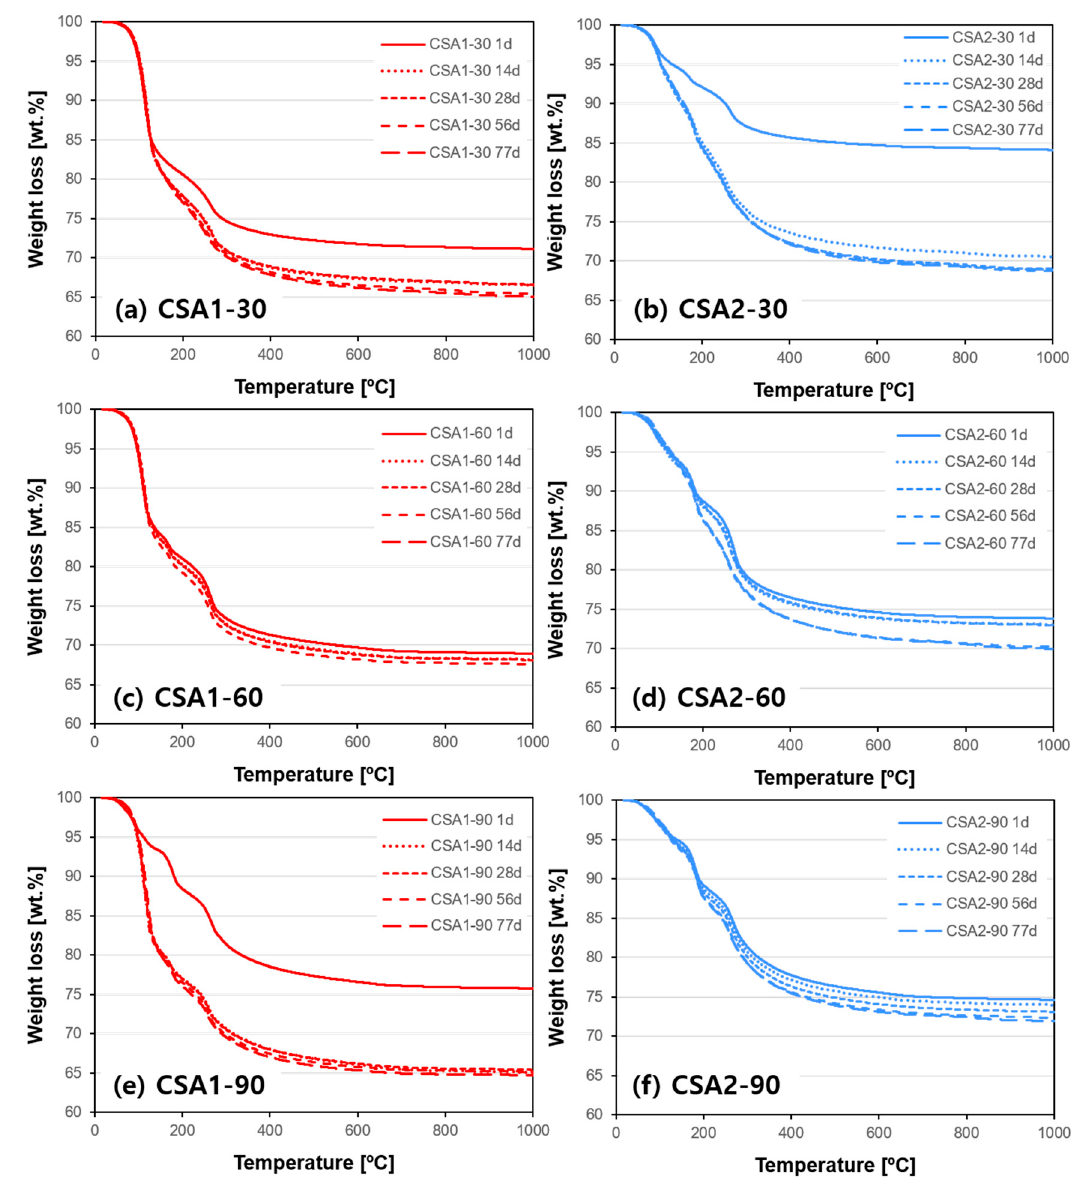
Figure 9. Weight loss curves obtained from thermogravimetric analysis (TGA) of each samples cured at ( a , b ) 30 °C, ( c , d ) 60 °C, and ( e , f ) 90 °C.